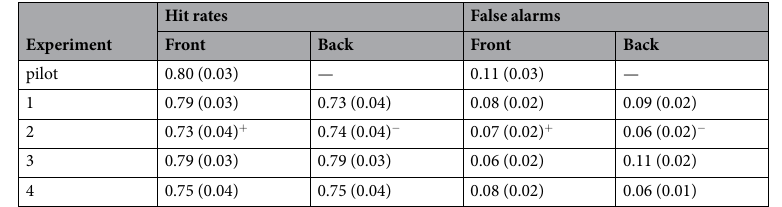
Table 1. Means for hit and false alarm rates at the front and the back planes in Experiment 1–4 and the pilot study. Note: + large size condition; − small size